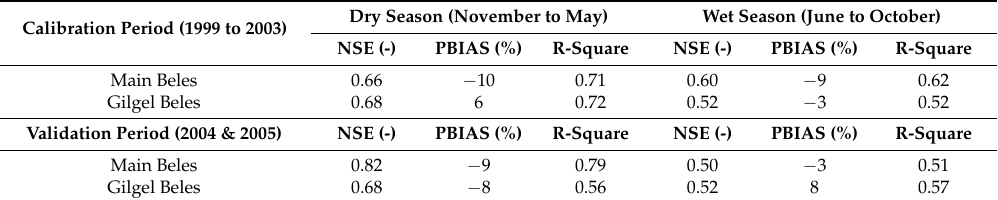
Table 2. Seasonal performance of HBV simulated streamflow vs. observed streamflow for the calibration and validation period of Main and Gilgel Beles subbasins.